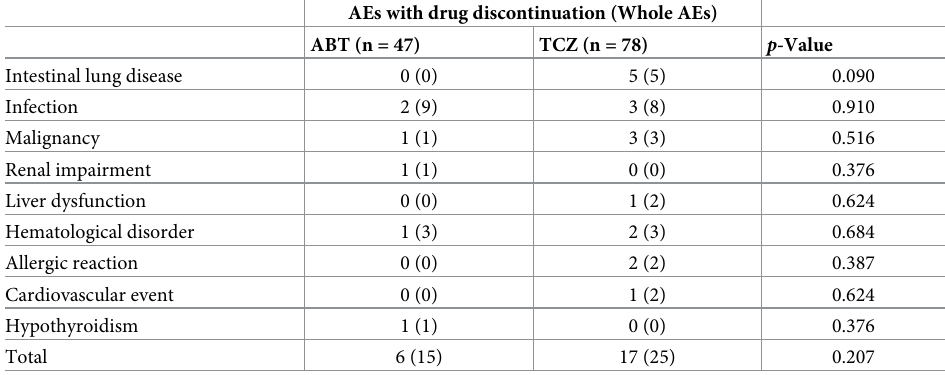
Table 2. All adverse events and adverse events lead to drug discontinuation in ABT group and TCZ